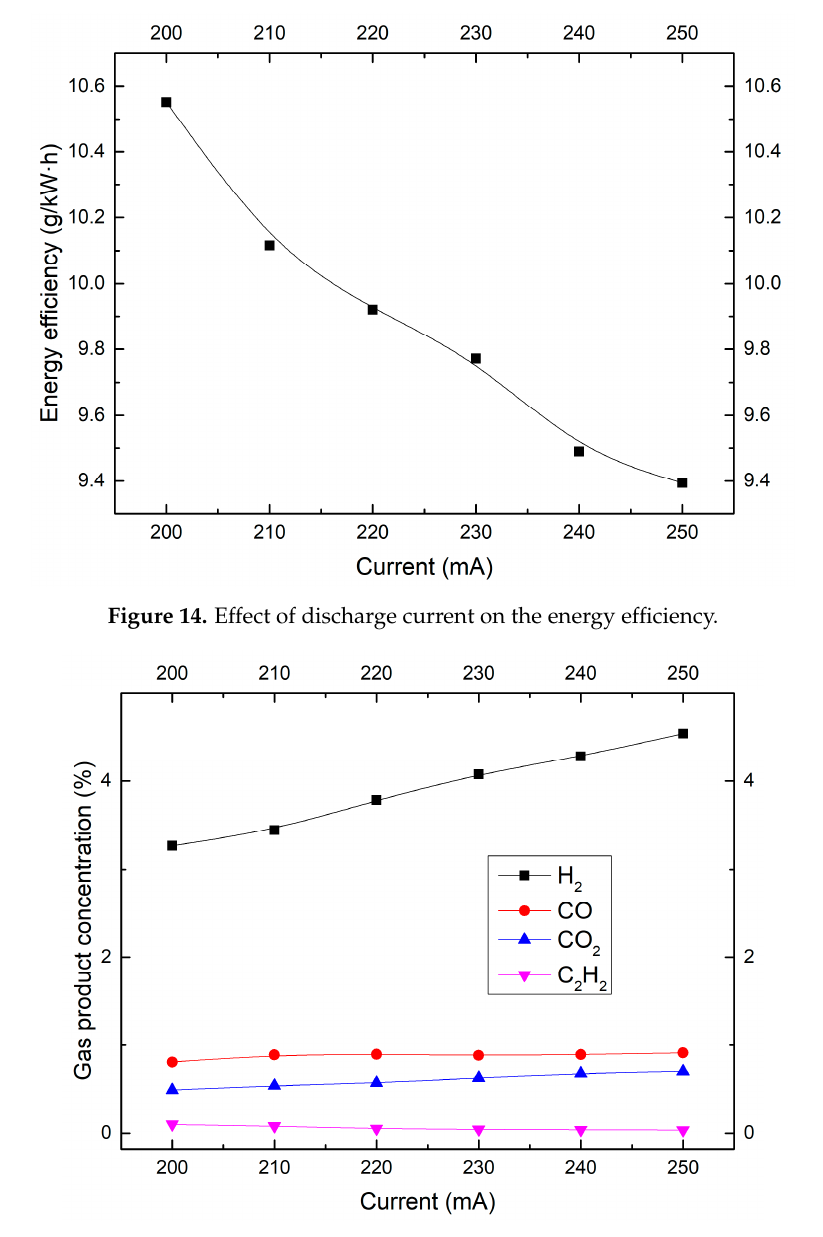
Figure 13. Effect of discharge current on destruction efficiency.